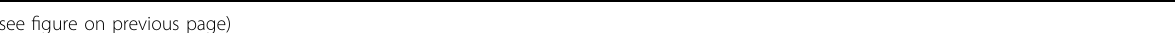
Fig. 5 Heritable DMRs have alterative DNA methylation reestablishment proportions and levels in the PS stage during embryonic reprogramming process. a Mean DNA methylation levels in different embryo stages and sperm samples. b Distribution of the CpG dinucleotides in different DNA methylation levels. c Alterations in DNA methylation patterns of both the heritable and the un-heritable de-methylated F 0 -DMRs when compared with that of the paternal sperm samples during reprogramming process of the F 1 generation. Total de-methylated (Total-hypo) events were composed of free-methylated (Free-hypo) events and the other de-methylated (Other-hypo) events, while total re-methylated (Total-hyper) events were composed of full-methylated (Full-hyper) events and the other re-methylated (Other-hyper) events. d Alterations in DNA methylation patterns of both the heritable and the un-heritable re-methylated F 0 -DMRs when compared with that of the paternal sperm samples during the reprogramming process of the F 1 generation. e Dynamic DNA methylation patterns of the stress-induced heritable de-methylated DMRs during reprogramming process. In each stage, all DMRs were classi fi ed into three types: hypo (stress group was de-methylated), hyper (stress group was re- methylated), and unchanged (there was no difference between two groups). Theoretically, there were 36 combinations of the reprogramming patterns of these DMRs. f Proportion of each DMR type in each embryo stage. g The top two reprogramming patterns of the DMRs that were sequencing covered in all embryo samples of both the control and stress